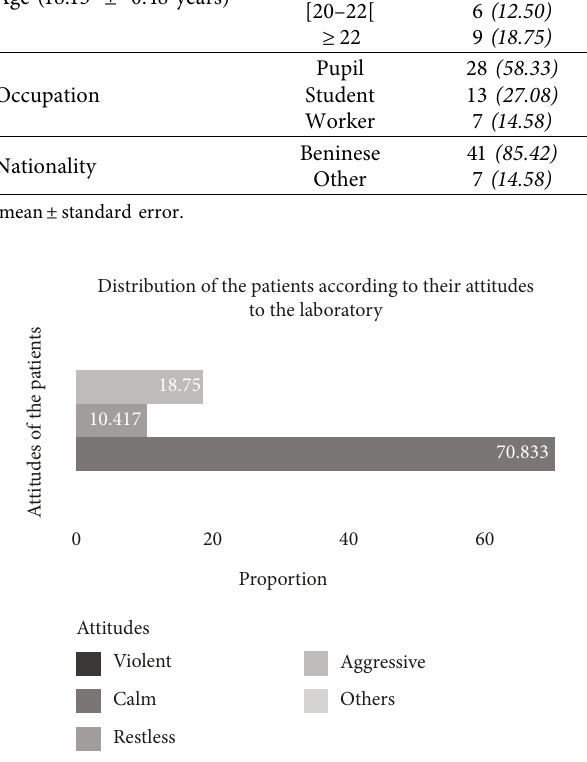
Figure 1: Distribution of the subjects according to their attitudes.